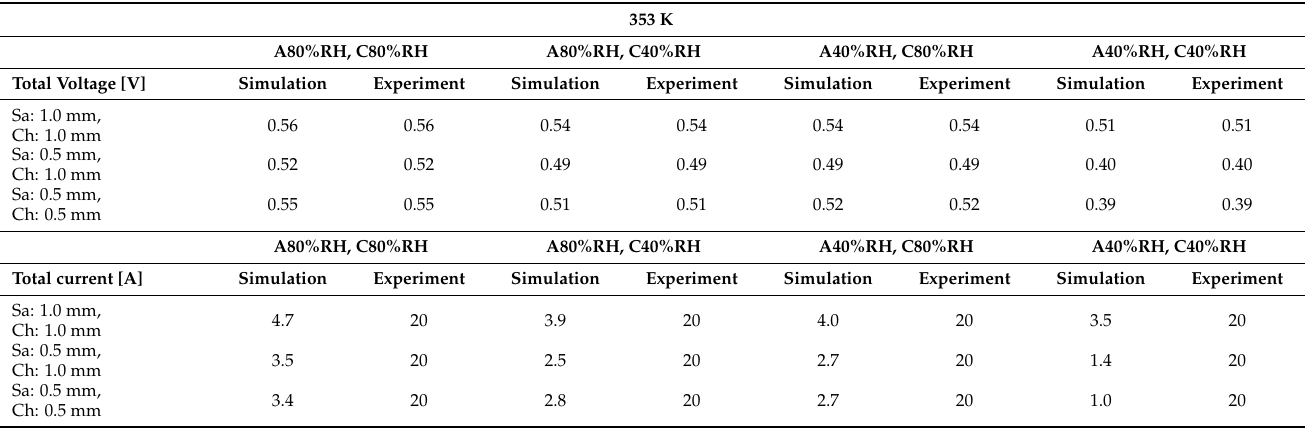
Table 7. Comparison of total voltage and total current between the numerical simulation in this study and the authors’ previous experimental study at 353 K [18].